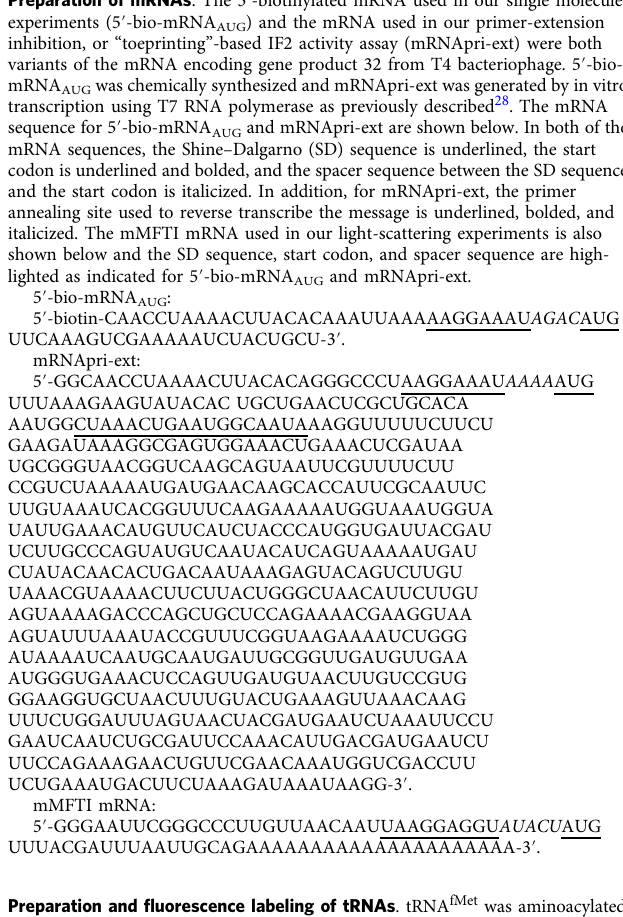
Preparation of mRNAs . The 5 ′ -biotinylated mRNA used in our single molecule experiments (5 ′ -bio-mRNA AUG ) and the mRNA used in our primer-extension inhibition, or “ toeprinting ” -based IF2 activity assay (mRNApri-ext) were both variants of the mRNA encoding gene product 32 from T4 bacteriophage. 5 ′ -bio- mRNA AUG was chemically synthesized and mRNApri-ext was generated by in vitro transcription using T7 RNA polymerase as previously described 28 . The mRNA sequence for 5 ′ -bio-mRNA AUG and mRNApri-ext are shown below. In both of the mRNA sequences, the Shine – Dalgarno (SD) sequence is underlined, the start codon is underlined and bolded, and the spacer sequence between the SD sequence and the start codon is italicized. In addition, for mRNApri-ext, the primer annealing site used to reverse transcribe the message is underlined, bolded, and italicized. The mMFTI mRNA used in our light-scattering experiments is also shown below and the SD sequence, start codon, and spacer sequence are high- lighted as indicated for 5 ′ -bio-mRNA AUG and mRNApri-ext.